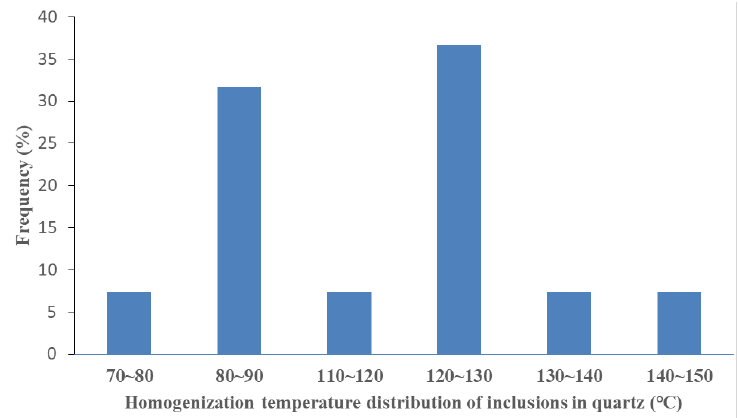
Figure 6. The homogenization temperature distribution of fluid inclusions.